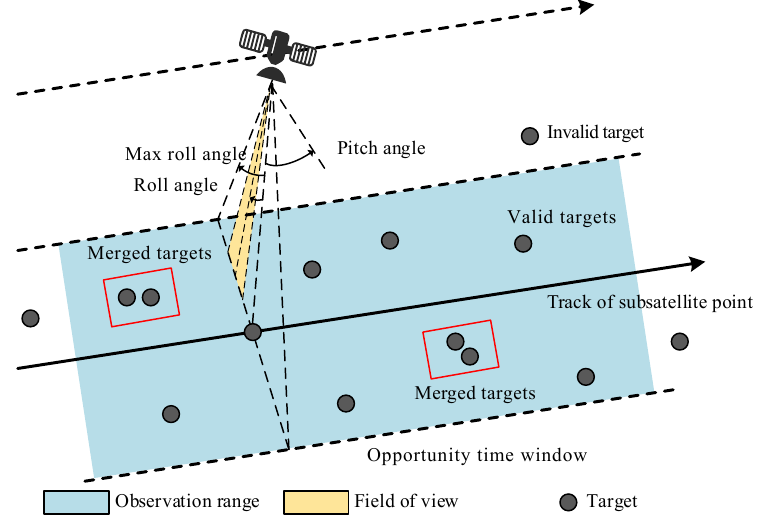
Figure 1. EOS observes targets in